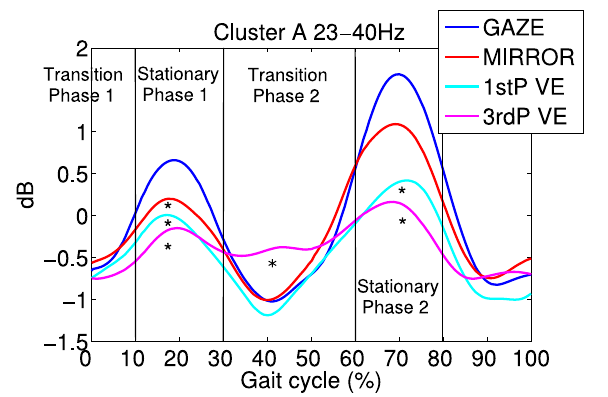
(ERSPs) for cluster A: for each feedback condition ERSPs are computed relative to the full gait cycle baseline obtained from the noFB condition. Then ERSPs are averaged over subject specific frequency bands between 23 and 40HZ and then averaged over subjects for cluster A. Temporally aligned events are marked for the right leg heel contact at 0% as the beginning and 100% as the end of the gait cycle, and for the left heel-strike at 50%. Each feedback condition is represented by a colored trace. It is visible that during 1stP and 3rdP VE in stationary gait phases (10–30% and 60–80%) power in this band is decreased compared to the other feedback conditions. Also a difference between 3rdP VE and 1stP VE during the second transition phase of the gait cycle (30–60%) is evident. Vertical lines mark the beginning and the end of gait cycle phases. Asterisks mark significance between feedback conditions in the indicated gait cycle